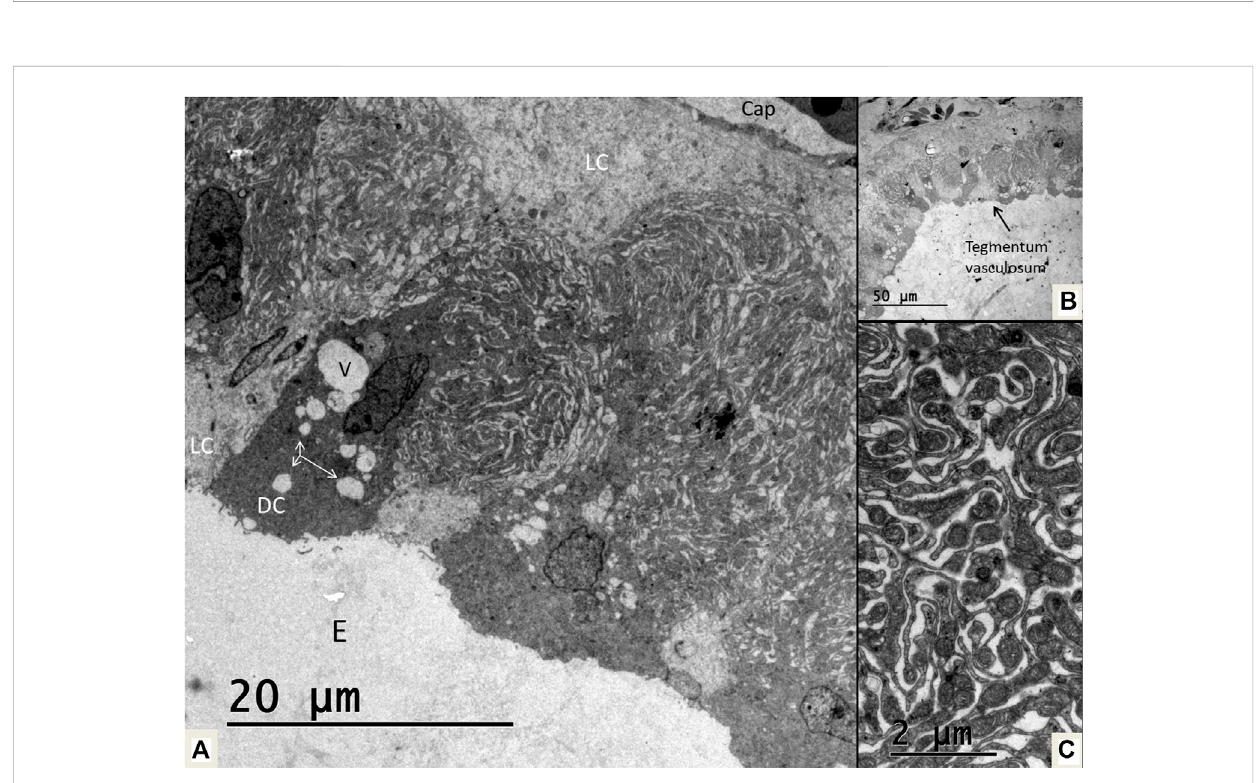
FIGURE 14 (A) Electron microscopy of the tegmentum vasculosum in the crocodile. There are both dark (DC) and light cells (LC). The dark cells contains secretory-like vesicles (V and arrows). Basally light cell face the basal lamina and a subepithelial capillary (Cap). (B) . Low power view of the tegmentum vasculosum. (C) . Extensive folds of the dark cells contain multiple mitochondria. E,